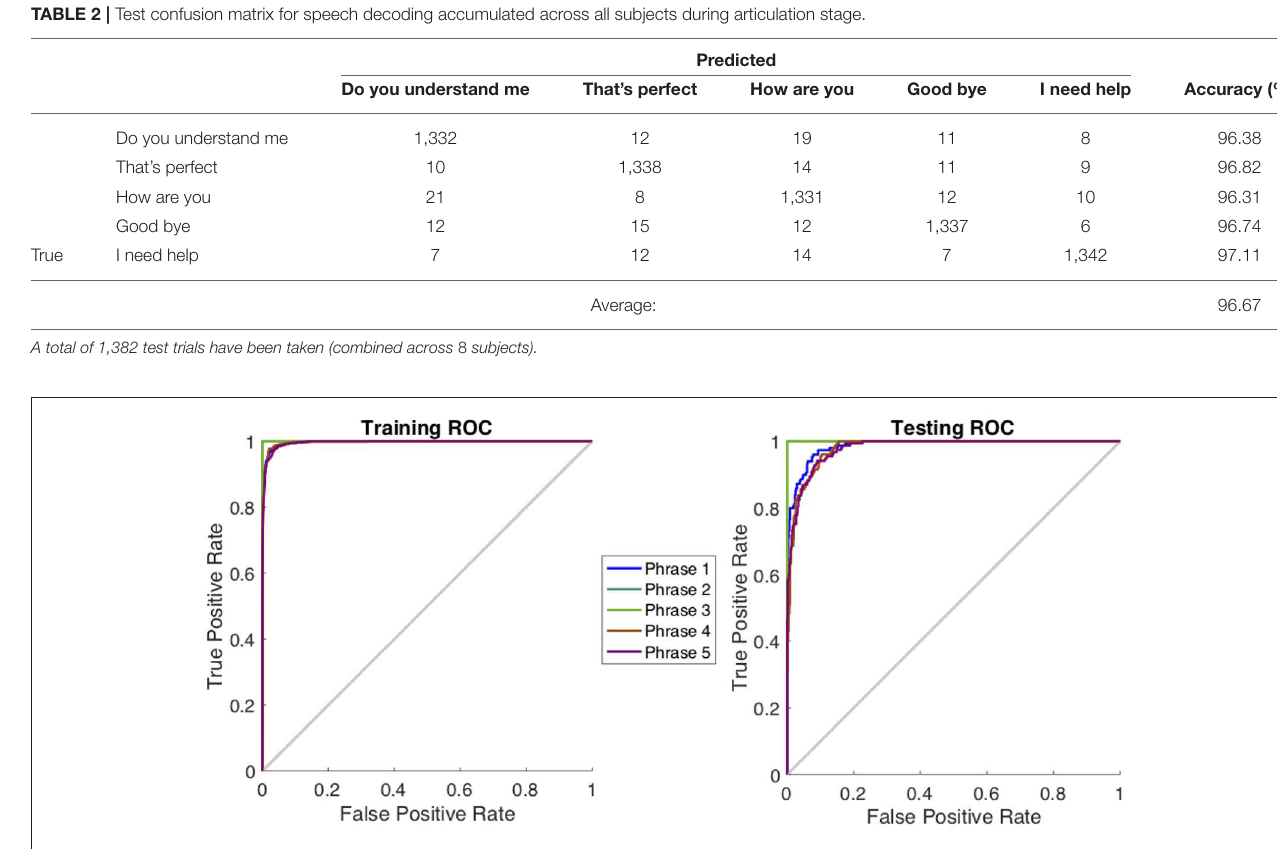
FIGURE 9 | Receiver operating characteristics curve for one subject during the classification of phrases in the articulation stage using AlexNet. The plot represents the variation between true positive rate (sensitivity) and true negative rate (1-specificity) to indicate the classification performance. For this curve average AUC >0.96 indicating a very high classification